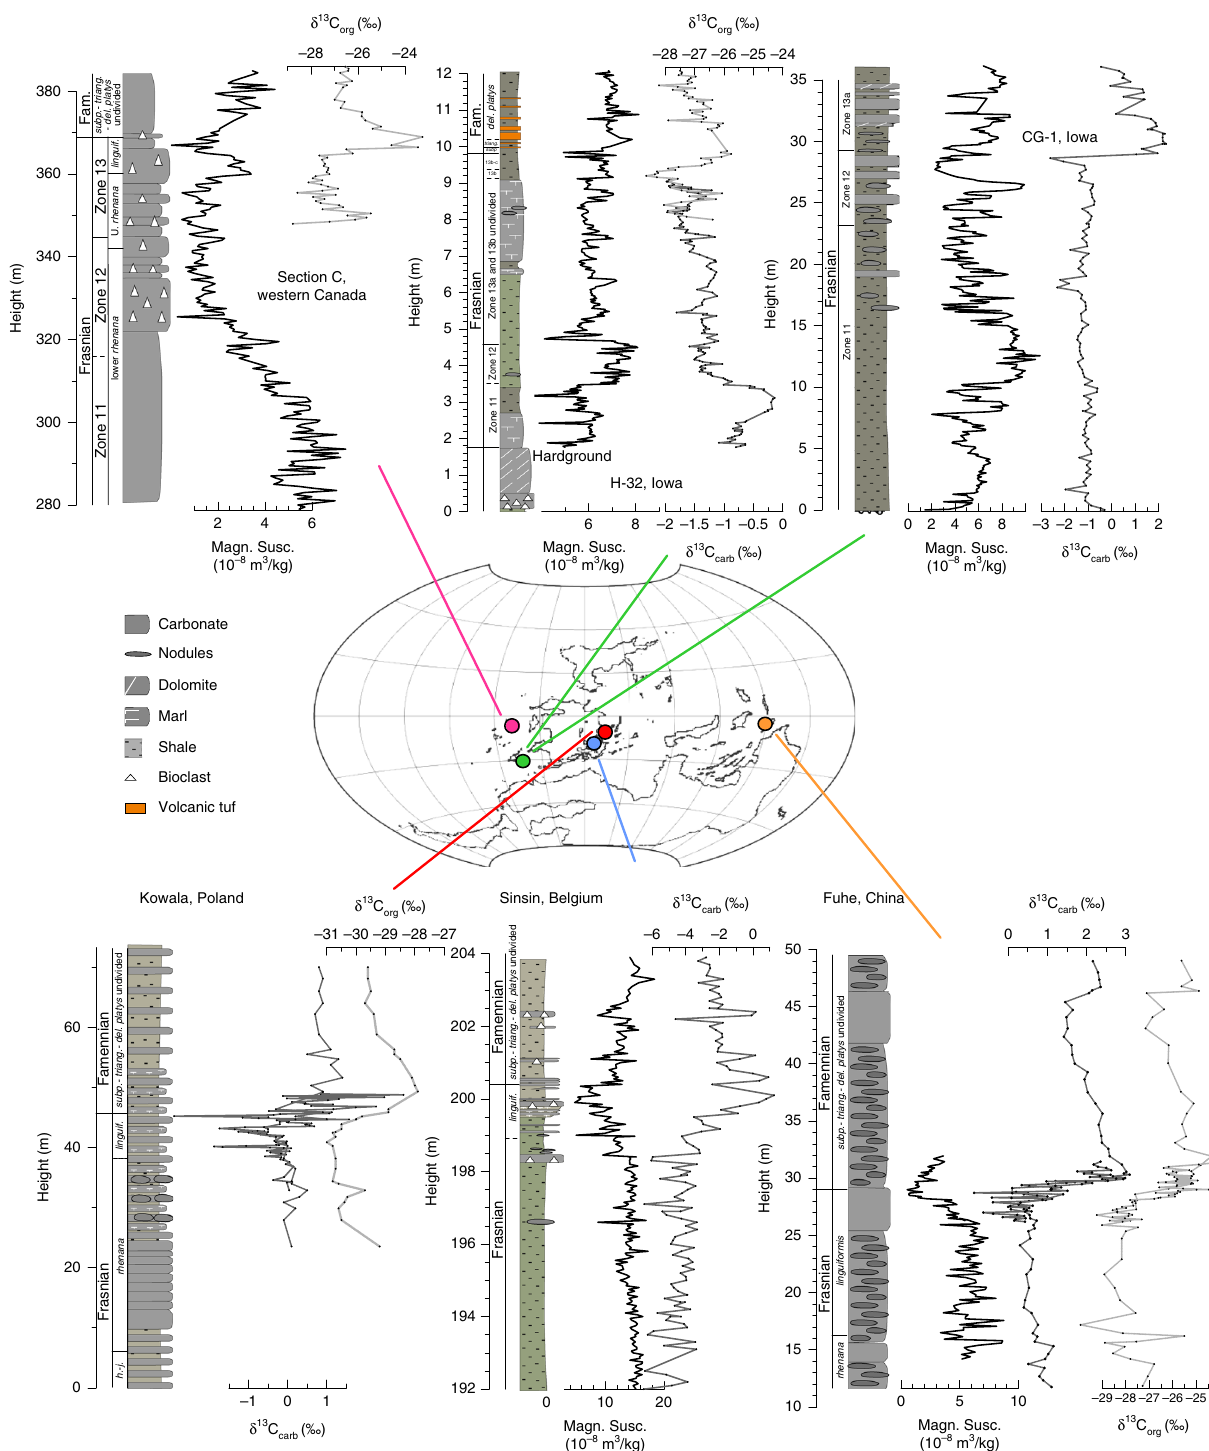
Fig. 1 Frasnian – Famennian magnetic susceptibility and δ 13 C carb stratigraphies for six globally distributed sections. H-32, CG-1, Sinsin proxy records, and H- 32 and CG-1 biostratigraphy were constructed in the framework of this study. The conodont biostratigraphy for the Sinsin section is from Sandberg et al. 58 . Section C (western Canada) magnetic susceptibility and biostratigraphy come from Whalen and Day 18 and the δ 13 C carb data from Whalen et al. 17 . High- resolution δ 13 C data from Kowala are from De Vleeschouwer et al. 16 , whereas the low-resolution δ 13 C data and biostratigraphy come from Joachimski et al. 19 . Fuhe magnetic susceptibility data and high-resolution carbon isotope data are from Whalen et al. 3 , low-resolution carbon isotope data are